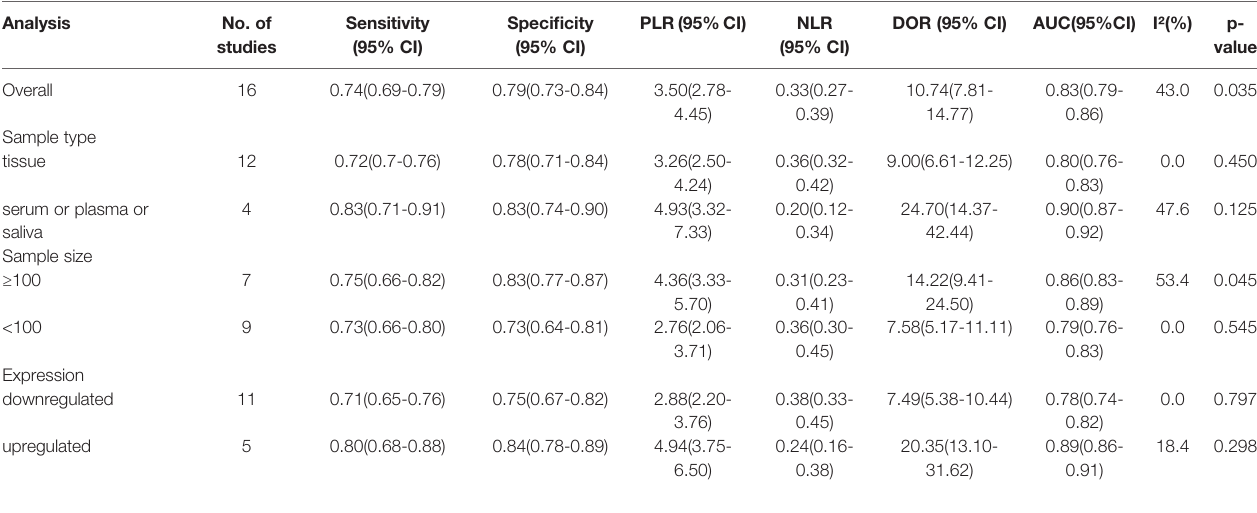
TABLE 2 | Results of subgroup analysis of cricRNAs reported by 16 studies in diagnostic